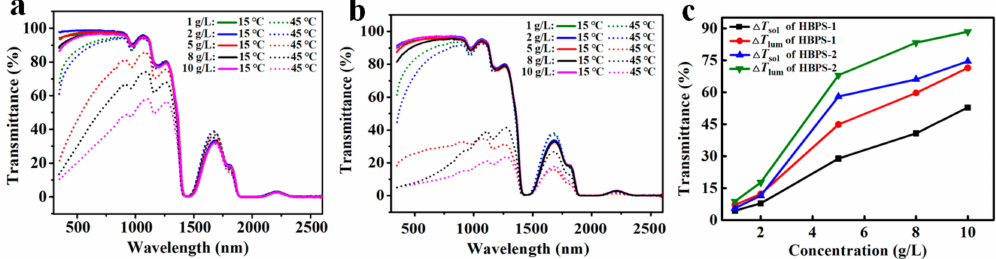
Figure 4. Transmittance curves of ( a ) HBPS-1 and ( b ) HBPS-2 with various concentrations between 1–10 g / L at 15–45 ◦ C; ( c ) A summary for the optical performance of temperature-responsive starch derivative samples (HBPS-1 and HBPS-2) under di ff erent concentrations (HBPS-1 and HBPS-2 have di ff erent substitution